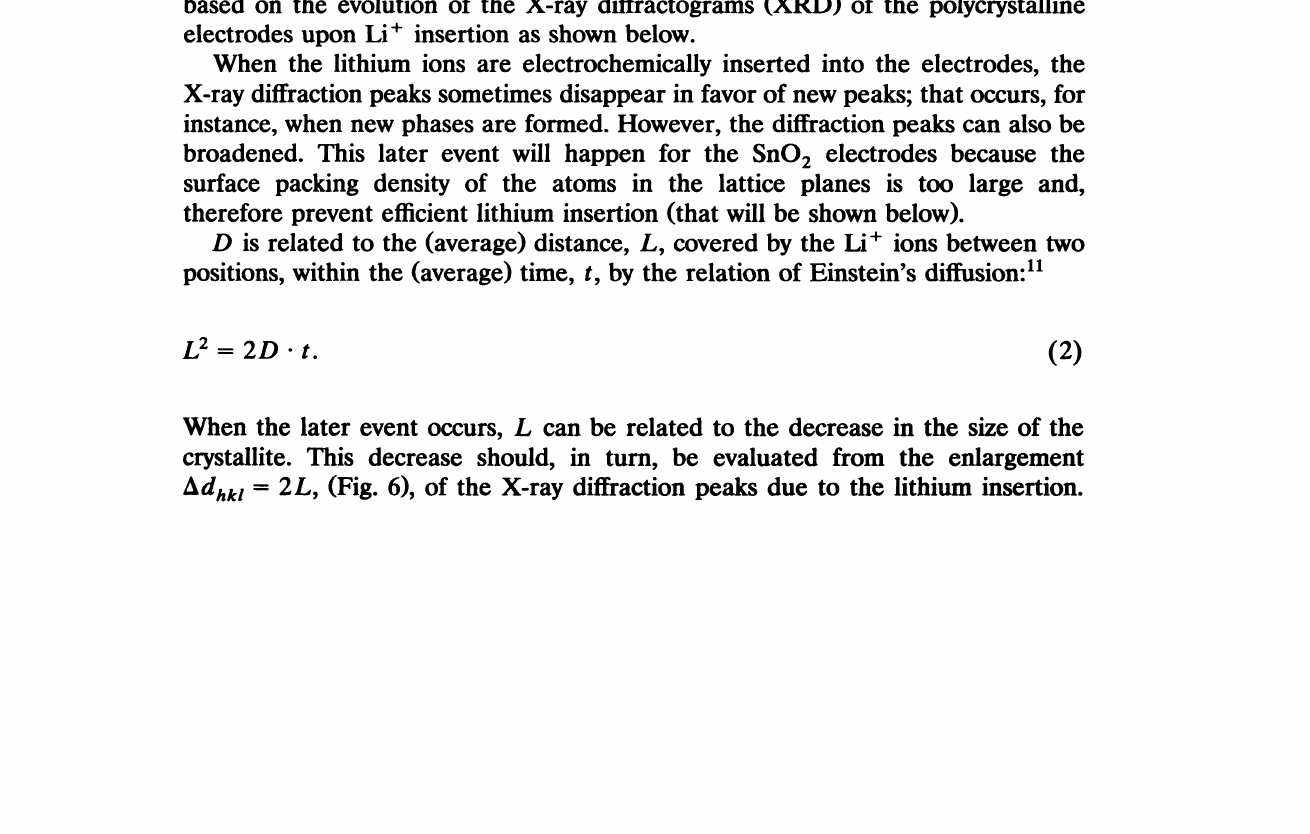
FIGURE 5 Series of charge-discharge curves of Li/Li + / LixSnO2l cells using fine-grained